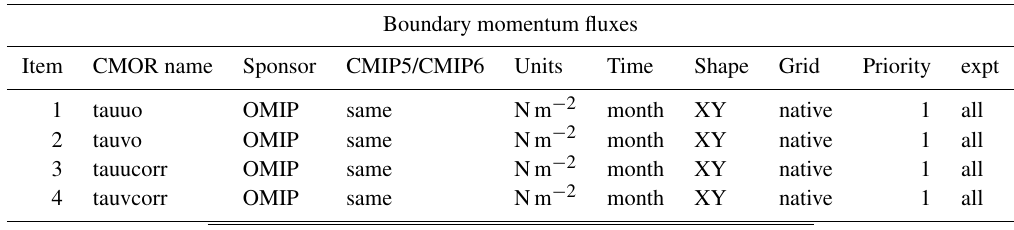
Table K4. This table presents the net surface stress applied at the liquid ocean surface due to air–sea plus ice–sea interactions. Positive fluxes accelerate the ocean in the given direction. The column indicating the experiment for saving the diagnostics generally says “all”, in which case we recommend the diagnostic be saved for CMIP6 experiments in which there is an ocean model component, including the DECK, historical simulations, FAFMIP, DAMIP, DCPP, ScenarioMIP, and C4MIP, as well as the ocean/sea-ice OMIP simulations. The units Nm − 2 are identical to Pascal. The lower sub-table relates the CMOR name to the CF standard